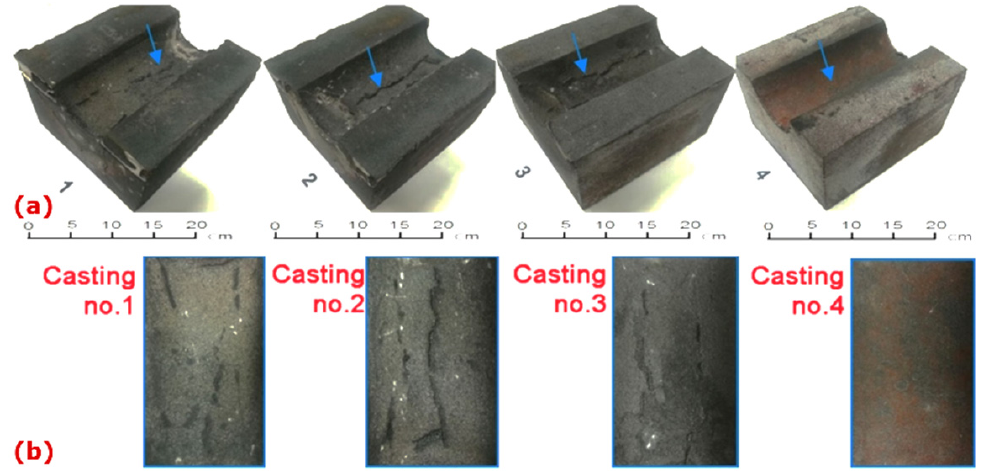
Figure 3. ( a ) Experimental castings 195 mm × 175 mm × 120 mm; area at interface mold/casting (blue arrows) ( b ) indicated areas with traces of interaction liquid metal/mold.